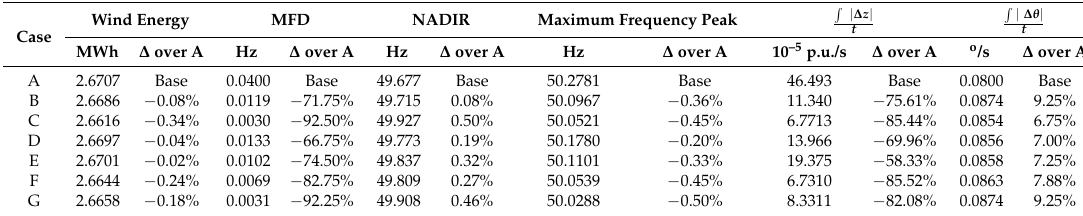
Table 6. Simulation results using variable wind